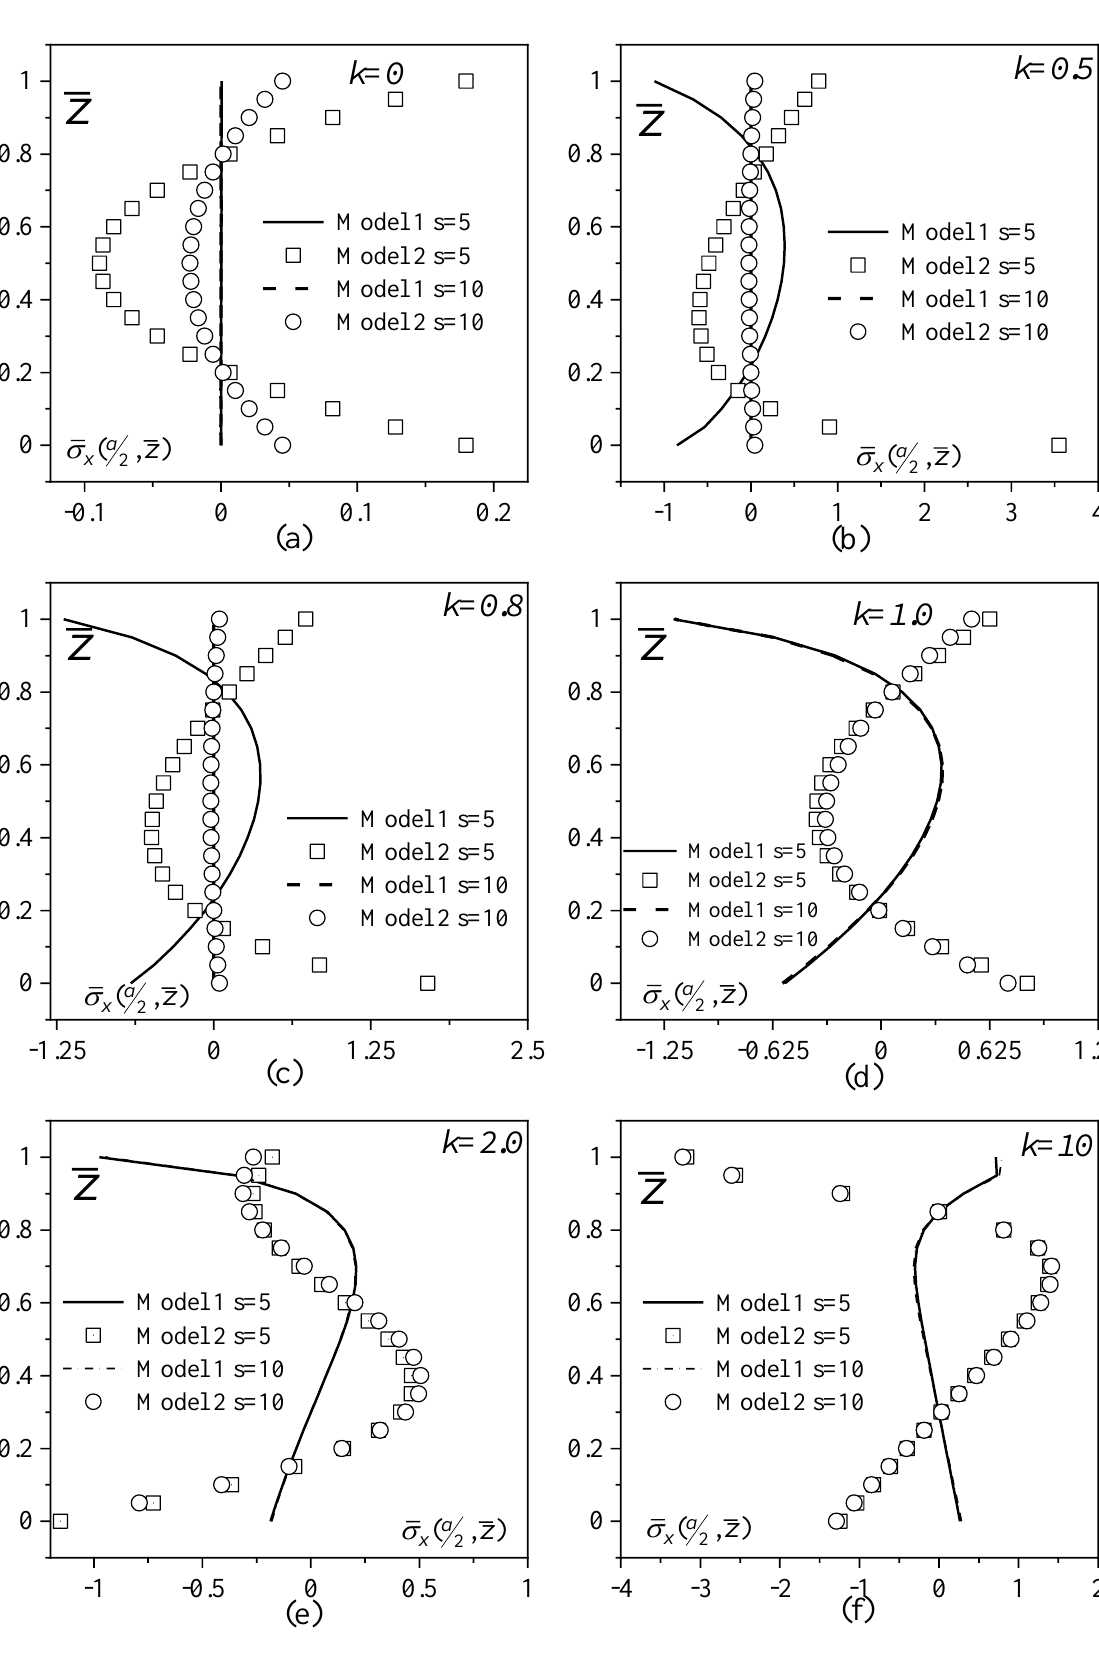
 ) for various graded FG laminate x [Material set